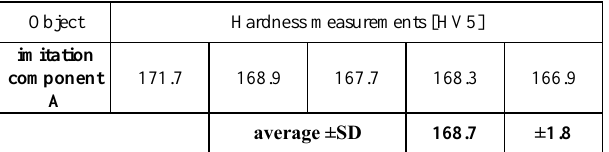
Table 7. Results of HV5 hardness measurements of sleeve B from belts imitating the original Object Hardness measurements [hv5] imitation component